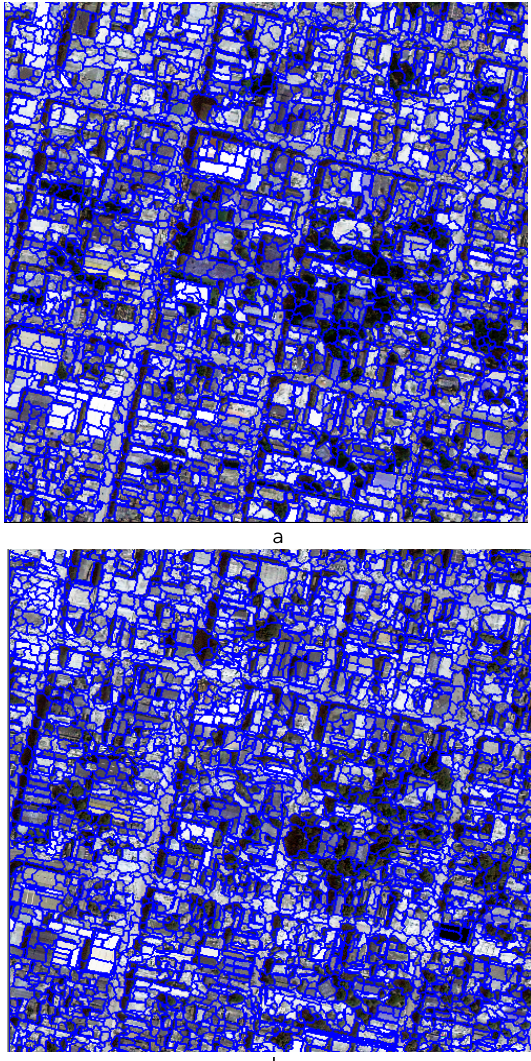
Figure 4: extracted image objects on pre- and post-earthquake image through multi-resolution segmentation algorithm. a) Pre- event image b) Post-event image Figure 3: Selected area as sample area. a) Pre-event image. b) Post event image.